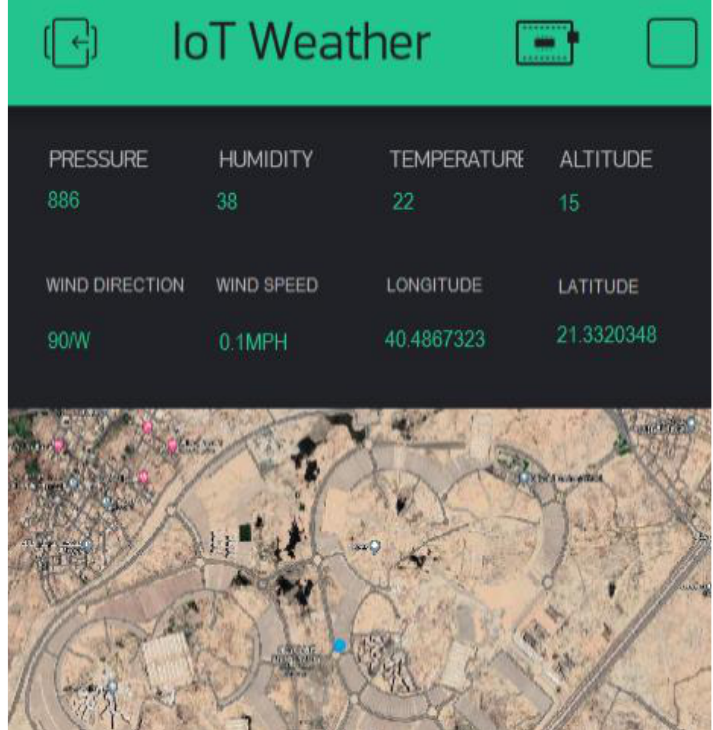
Figure 7. Weather conditions dashboard using Blynk